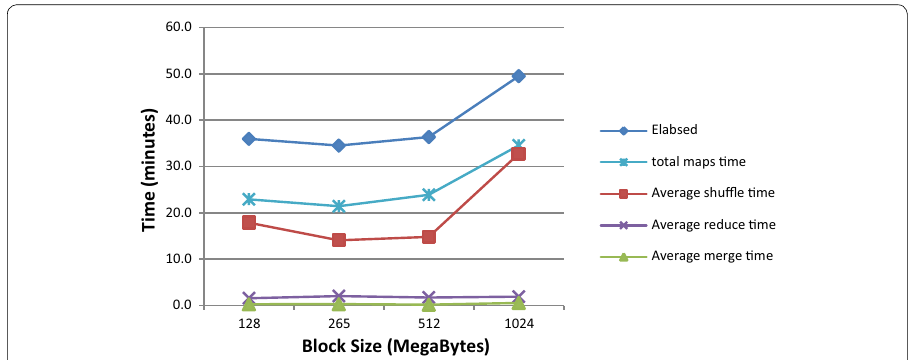
Fig. 27 Clustering 17.79 GB raster image with a 50 nodes